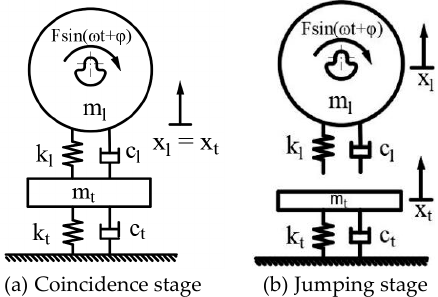
Figure 1. Dynamic model of “machine-pavement” system jumping condition. At the initial stage of movement, the “machine-pavement” system was in the stage of coincidence movement when the vibrating drum m l did not jump and moved together with the vibrating weight m t of the pavement structure, ignoring the influence of gravity. When the speed and displacement of the vibrating drum were all less than 0, the vibrating drum was considered to enter the jumping movement stage. At this stage, the vibrating drum was separated from the vibrating weight, there was no contact between the pave- ment structure and the vibrating device, and the effect of gravity could not be ignored. The dynamic equations of the system were established as expressed below: At coincidence stage